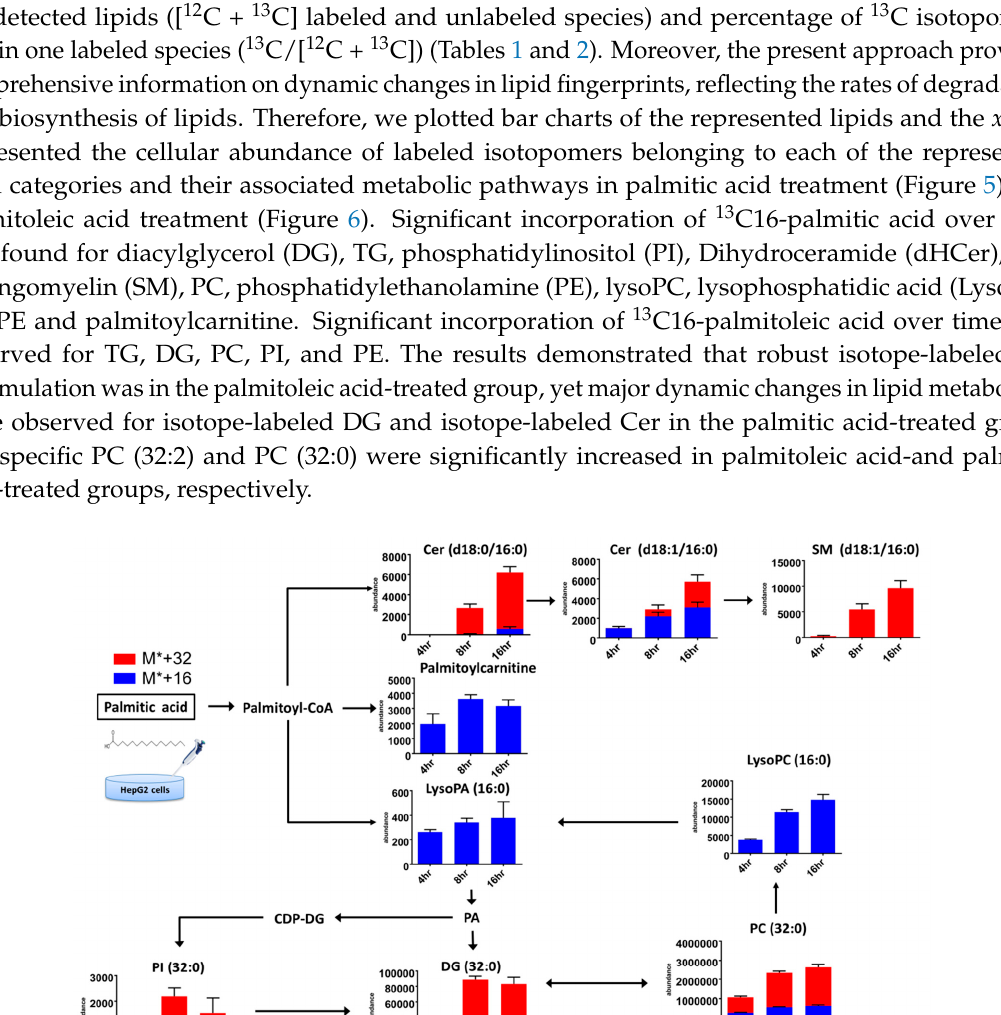
Figure 6. Metabolic pathways of and dynamic changes in lipid classes in HepG2 cells incubated for 4, 8, and 16 h with 0.3 mM 13 C16-palmitoleic acid. The cellular abundances of metabolites labeled with the stable isotope were marked as blue (M* + 16), red (M* + 32), and green (M* + 48) bar charts. (mean ± SD, n = 18, triplicates).